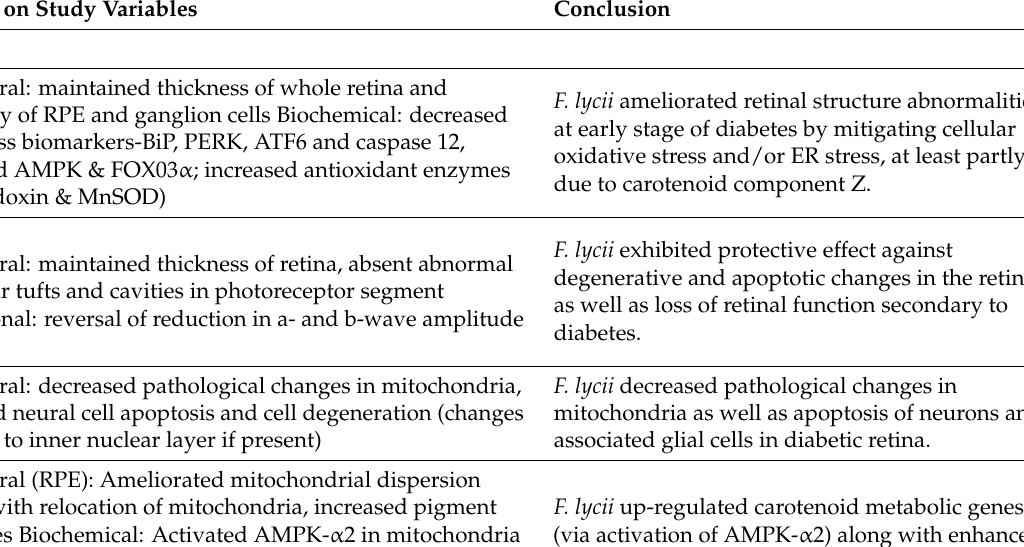
Table 3. List of studies that have evaluated F. lycii with respect to diabetic